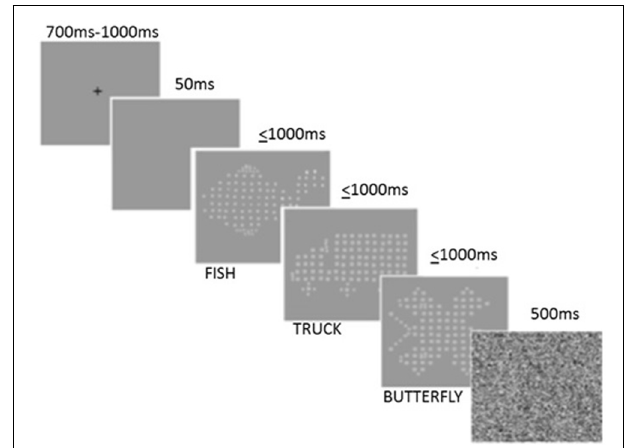
FIGURE 1 | Modified Inspection Time (IT) task trial. Note: only one target stimuli of fish, truck, or butterfly is presented per trial.